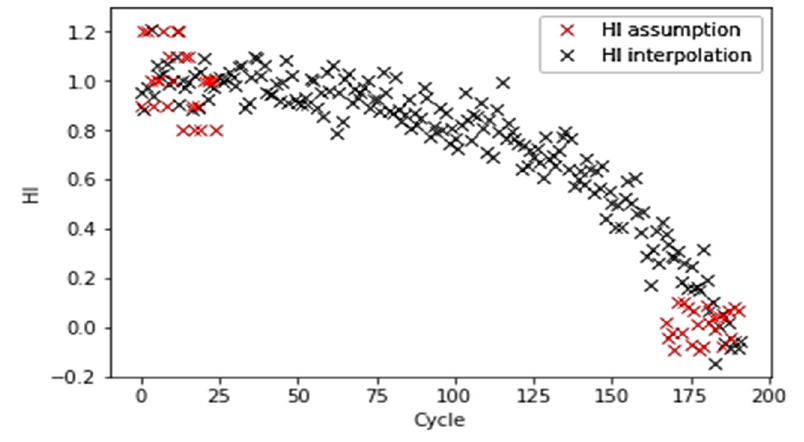
Figure 10. Linear interpolation by partial marked HI points.